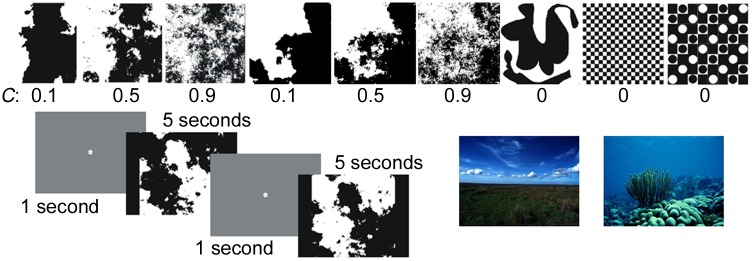
Examples of different fractal image stimuli which vary in spatial complexity from low (C = 0.1) to high (C = 0.9), along with examples of non-fractal images used (C = 0).Also shown in the lower left is the image viewing protocol, where participants focus on the screen center for one second between images. The lower right has two examples of natural landscape images used.